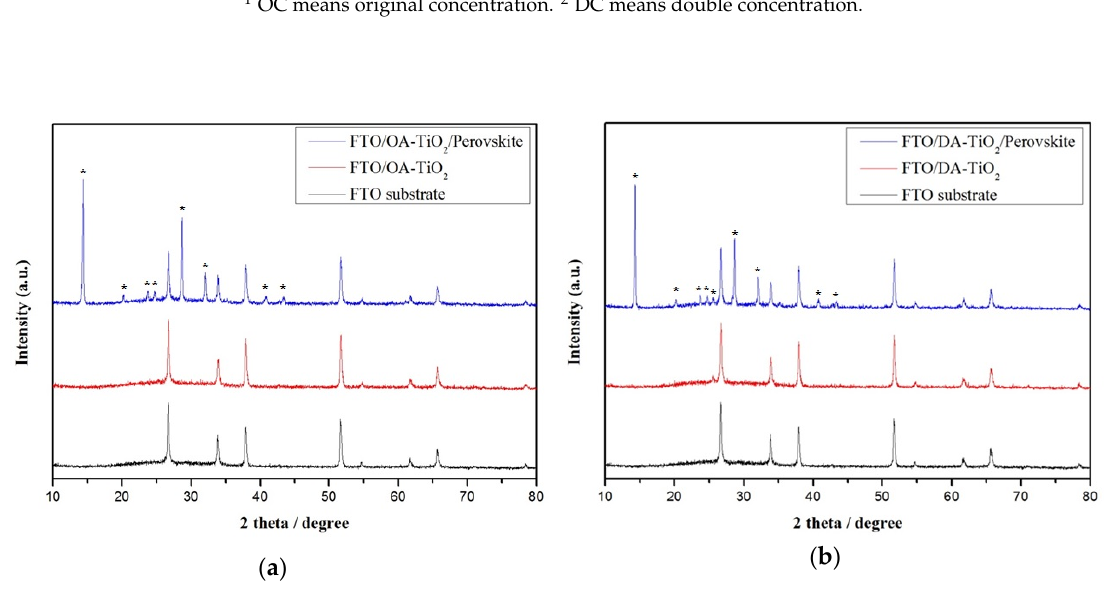
Figure 7. XRD results of ( a ) OC TiO 2 film and ( b ) DC TiO 2 film fabricated on fluorine-doped tin oxide (FTO) substrate.